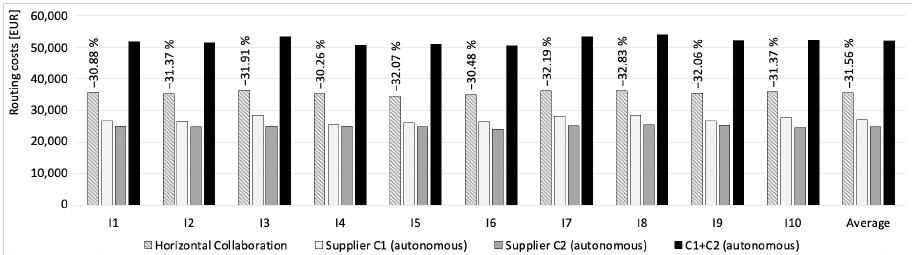
Figure 3. Routing costs [EUR] in the cases of autonomous and collaborative